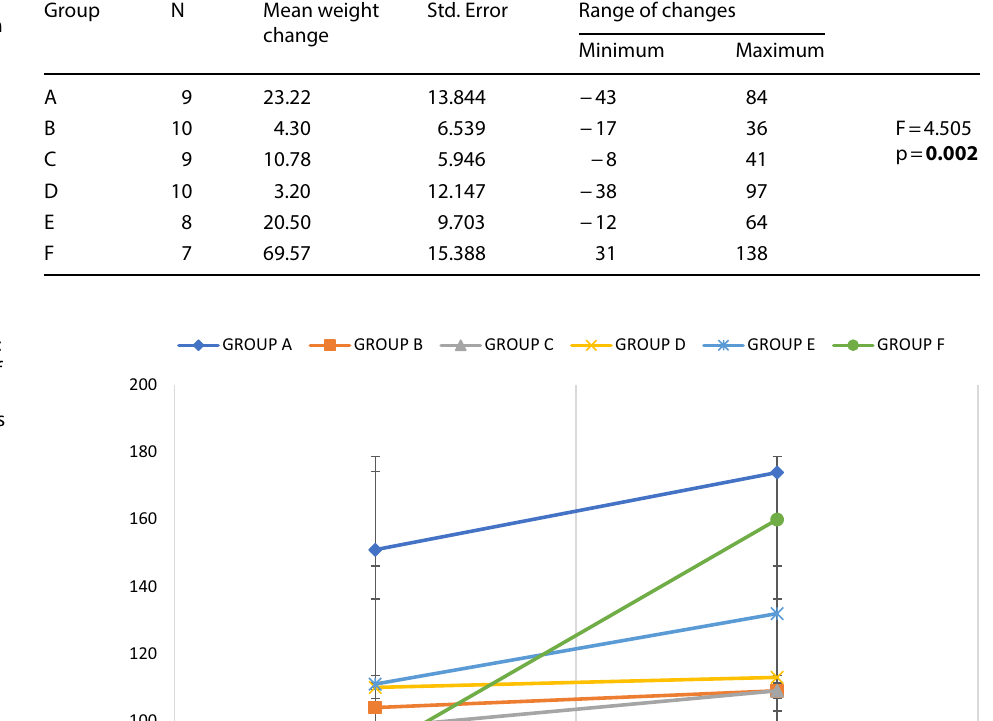
Table 2 Group comparisons of mean weight change from baseline